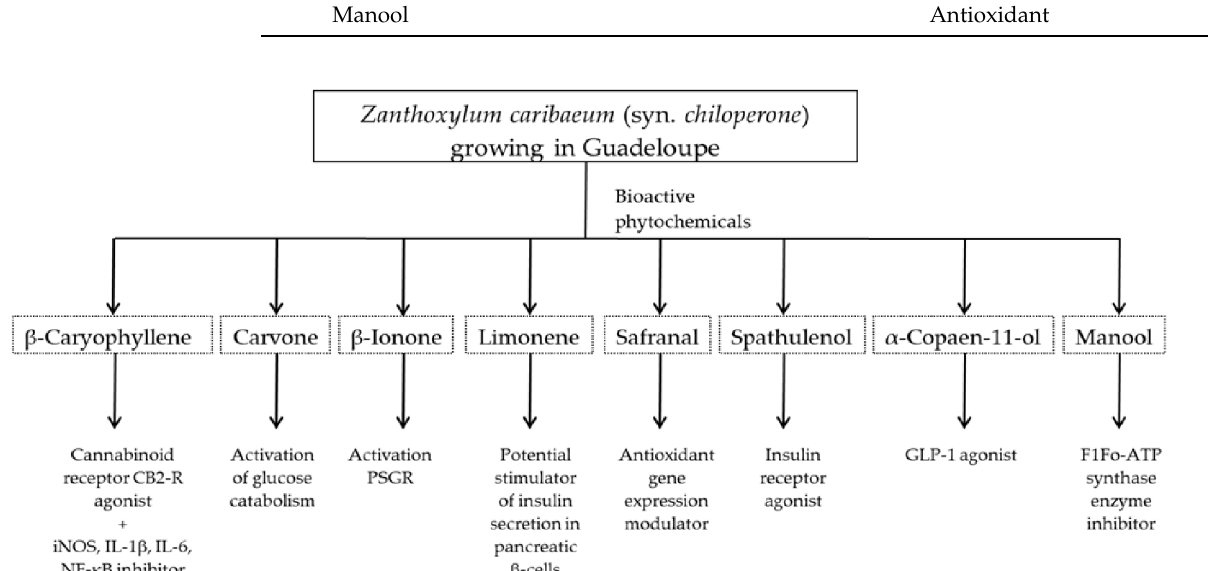
Figure 4. Antimetabolic mechanisms of the bioactive phytochemicals from Zanthoxylumcaribaeum growing in Guadeloupe.